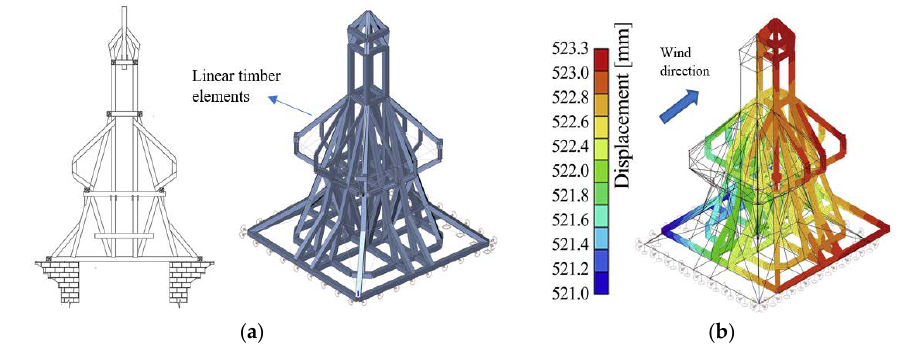
Figure 9. ( a ) Linear numerical modeling of a timber roof; ( b ) Displacement of each part